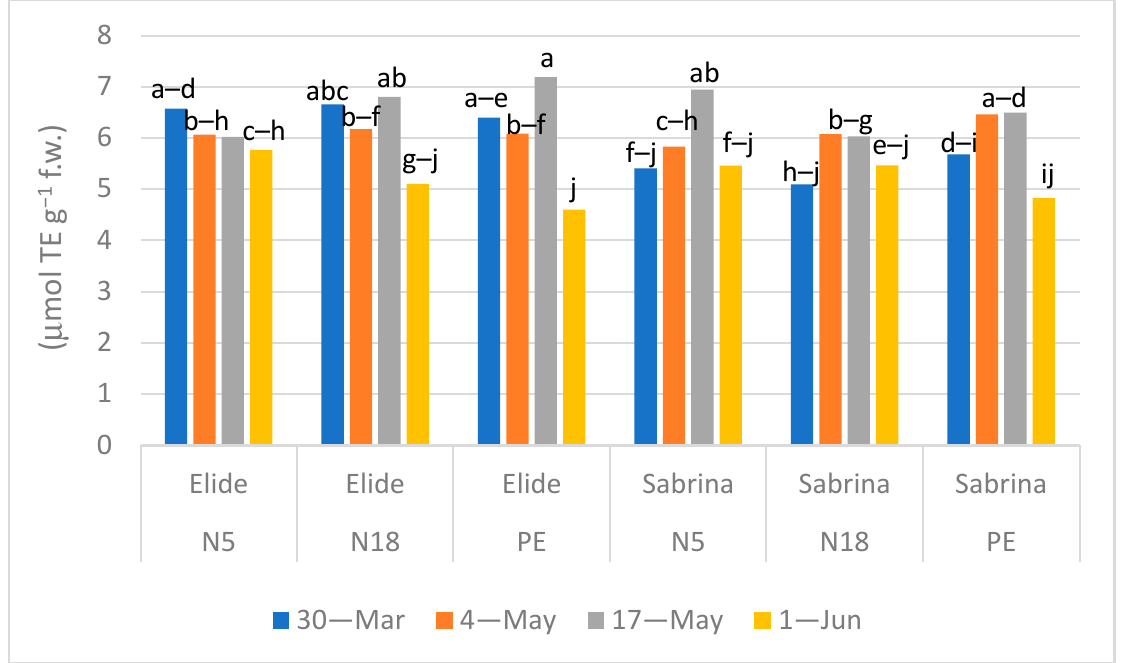
Figure 6. Effect of Mulch × Cultivar × Time of sampling interaction ( p < 0.0001) in antioxidant activity. Means followed by the same letters do not differ significantly according to Tukey HSD test ( p = 0.05).